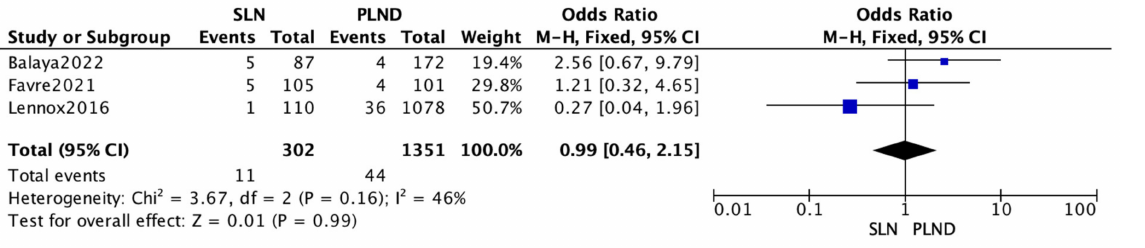
Figure 3. Overall